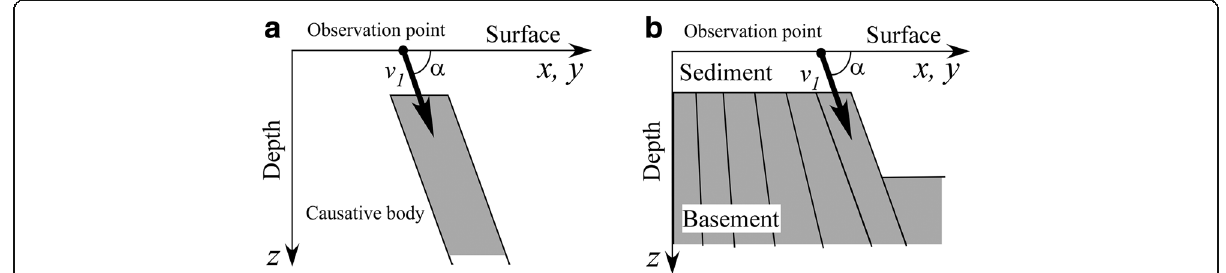
Fig. 1 Schematic illustration of the maximum eigenvectors for two-dimensional (2D) structures such as dykes and faults. a Basic model. In this figure, v 1 is the maximum eigenvector of the gravity gradient tensor and points to the causative body. The angle α between the surface and the maximum eigenvector is the dip of the causative body. b Fault model. A basement consists of an aggregate of high-density prisms, and the angle, α , indicates the fault